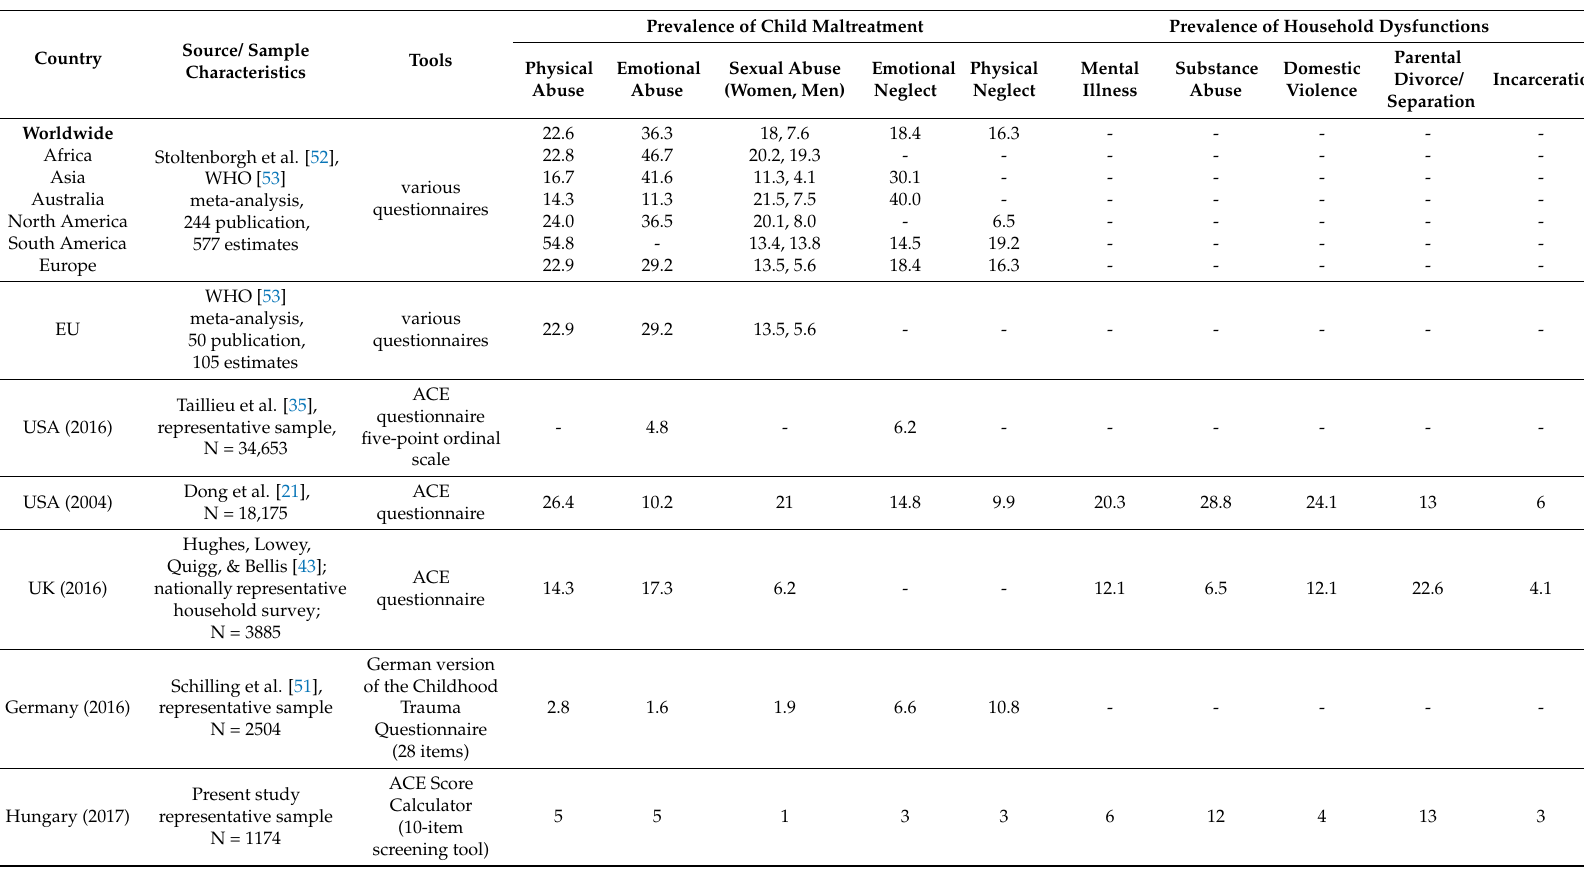
Table 8. A comparison of prevalence rates (estimates and measured data) of child maltreatment across the globe reported by adults.